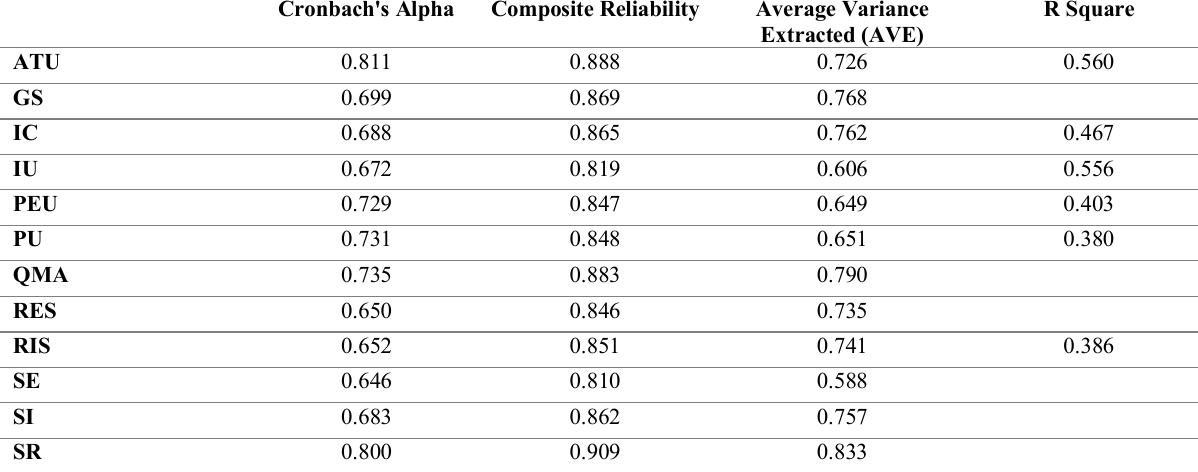
Table 2: Construct Reliability and Validity